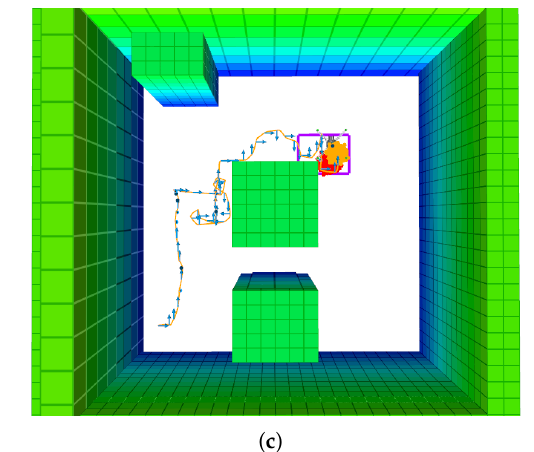
Figure 16. Anomalies on the amount of executed time steps in simulation. ( a ) Example trajectory with repopulated single cluster. ( b ) Example trajectory for an initially defined dual cluster, repopulated after low detection confidence values. ( c ) Example abnormal trajectory under a uniform